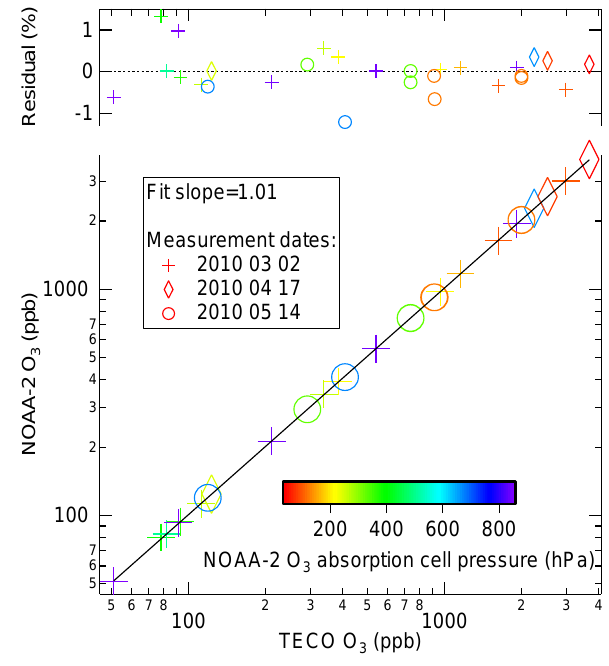
Fig. 8. Intercomparison between the NOAA-2 O 3 and the TECO O 3 primary standard instrument over a range of cell pressures in the NOAA-2 O 3 instrument. Each data point represents a 40-s average of O 3 mixing ratio in units of parts per billion (ppb). The slope of the linear best fit through the origin is 1.01 ± 0.01. The fit residuals are shown in the top